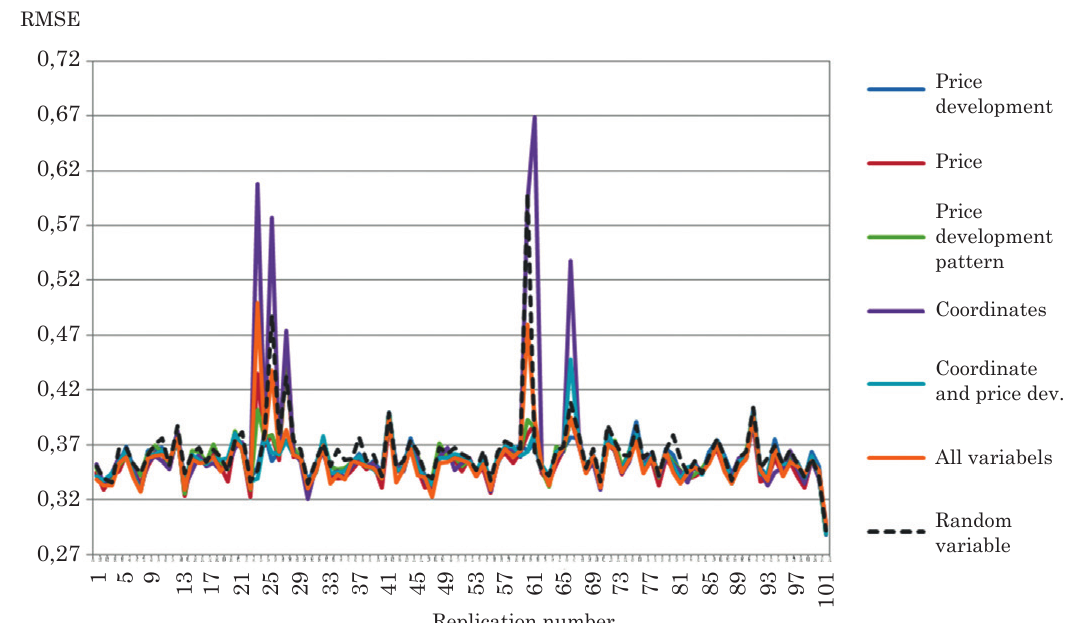
Figure 7. Variation of RMSE between the replications for the clustering methods in the smallest – not sorted